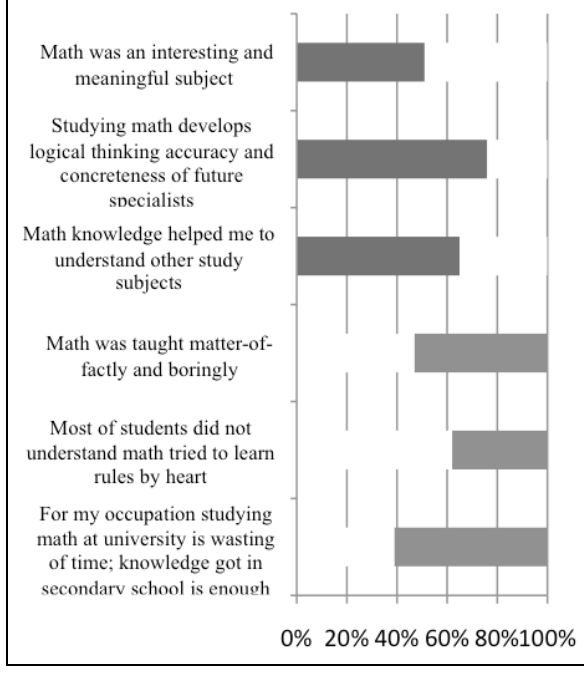
Figure 6. Assessment of practical potential of Mathematics